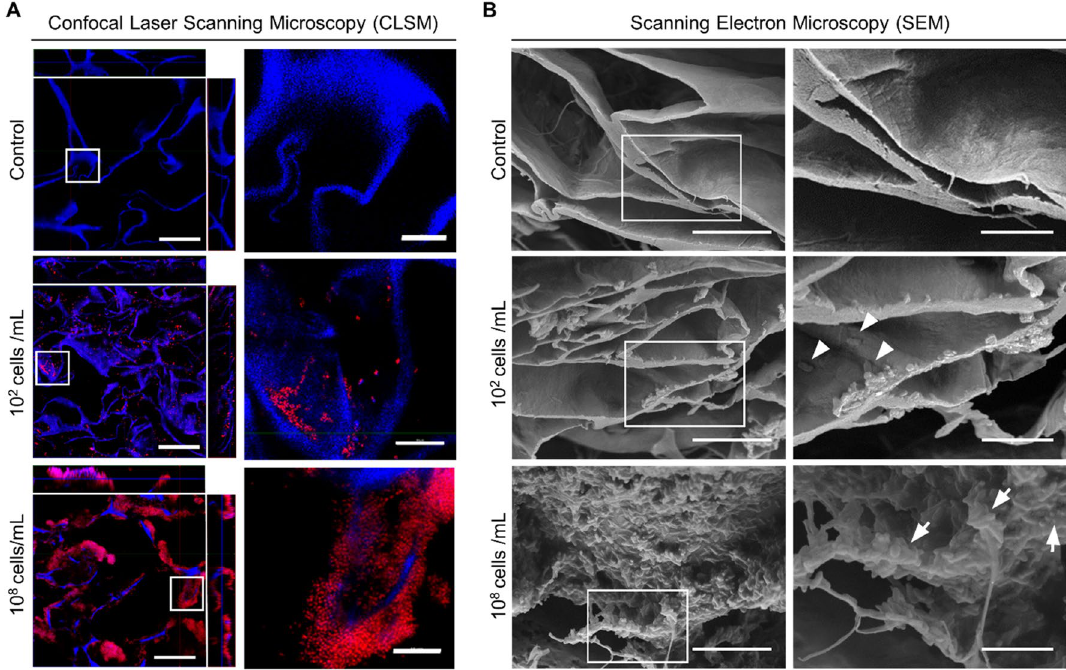
Figure 3. Microscopy characterization of biofilms formed in the scaffolds. ( A ) Fixed scaffolds were stained with PI (red) and DAPI (blue) for CLSM visualization, showing biofilm formation on scaffold fibers and bacterial aggregates (zoomed right panels). Side images from left panels represent a Z-view of two optical sections (X- and Y-view) from the scaffold. ( B ) SEM analysis shows individual cells (arrowheads) and bacterial aggregates (arrows) with EPS formation (zoomed right panels). Scale bars for A represent 50 µm (left panel) and 10 µm (right panel); for B represent 12 µm (left panel), 5 µm (right panel). In A, blue signal is present in all groups due to collagen autofluorescence.